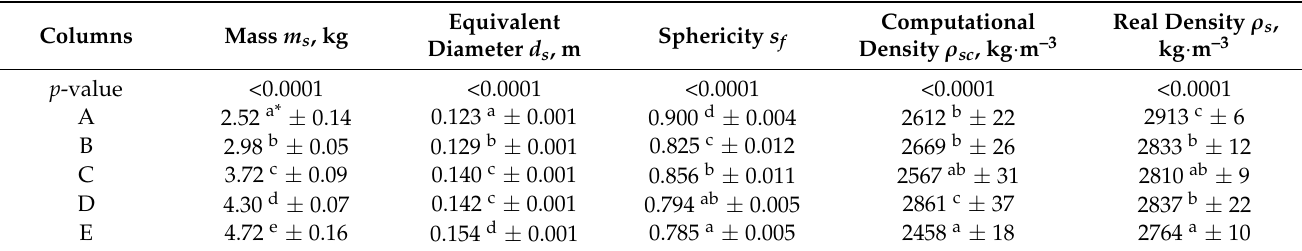
Table 5. Characteristics of stones; mean values and standard